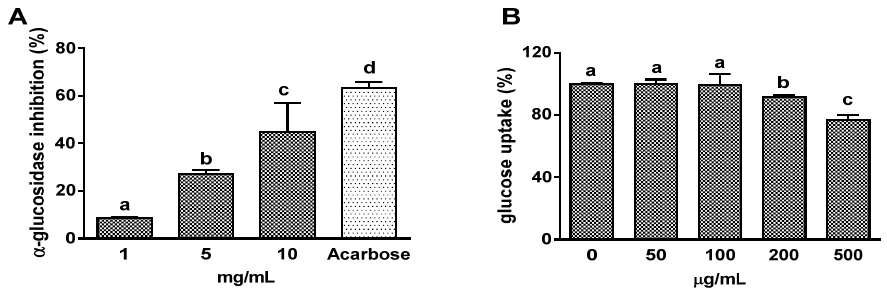
Figure 1. Effect of OFS (o puntia ficus-indica var . saboten ) on the inhibition of α -glucosidase activity ( A ) and BBMV glucose uptake ( B ). Intestinal brush border membrane vesicles (BBMV) were isolated from jejunum of ICR mice, and Na + -dependent glucose uptake was determined. Glucose uptake data are expressed as the percentage of control group. Each value is the mean ± SE ( n = 3). The bars with a different letter are significantly different from each other at the level of p < 0.05.